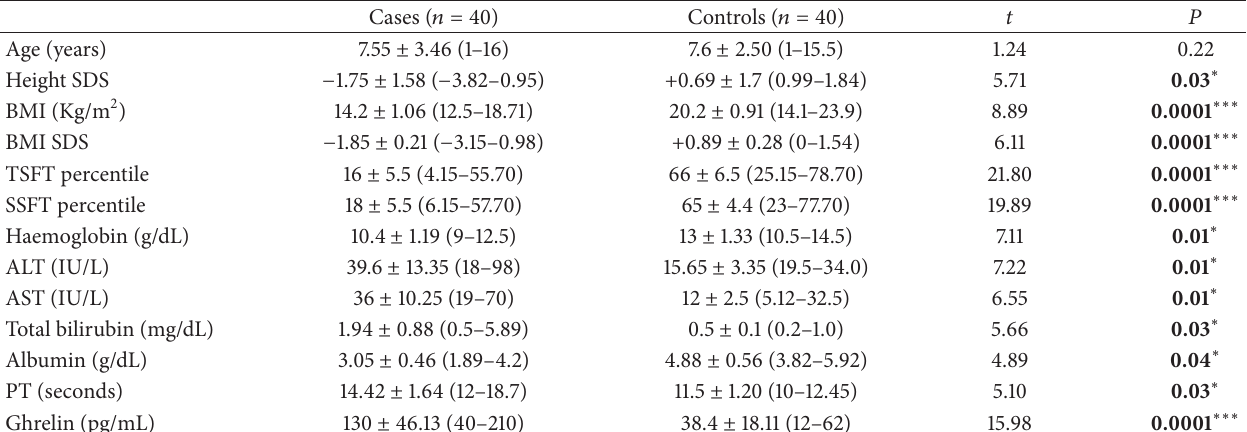
Table 1: Clinical and laboratory data among cases and controls.